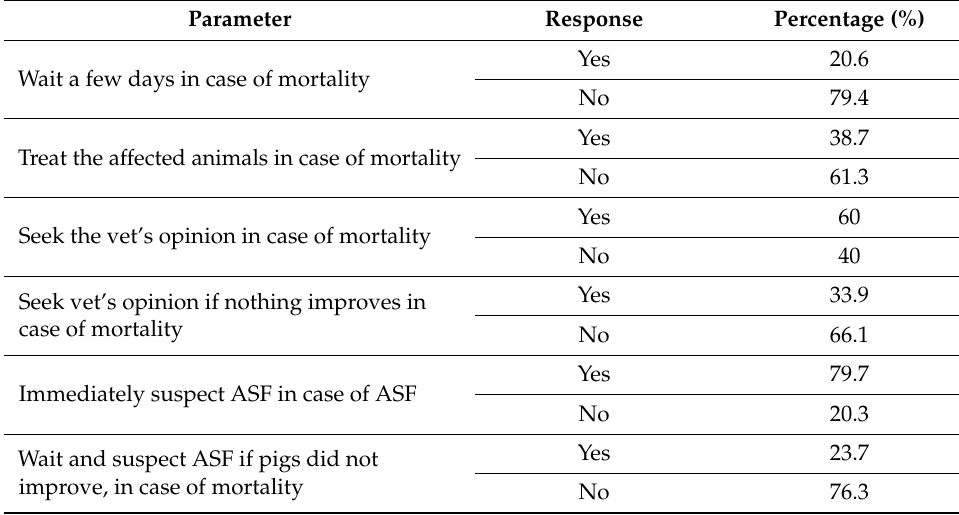
Table 7. Farmers reaction toward fever, redness on skin, reduced eating and no increase in mortality.